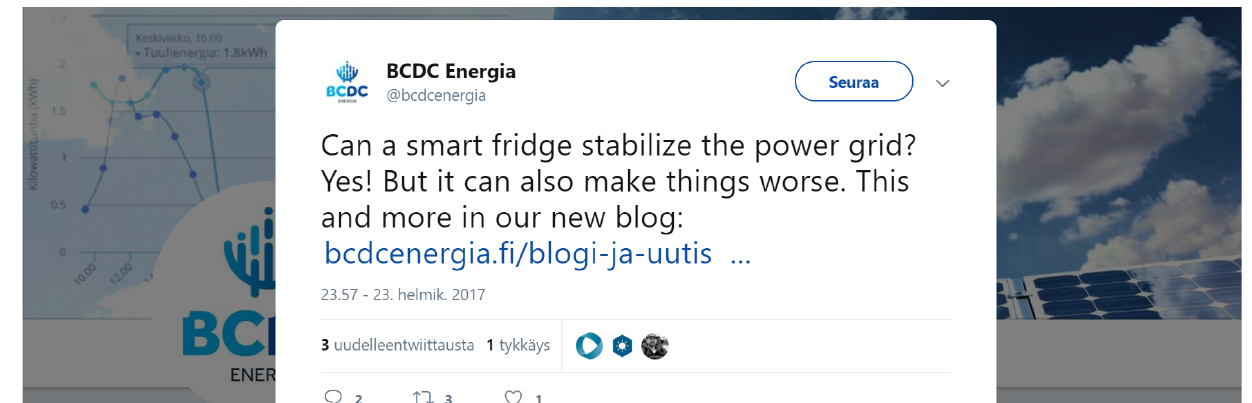
Figure 3. Luring with raising questions. Source: BCDC Energy (2017c). positive images and humanizes science.